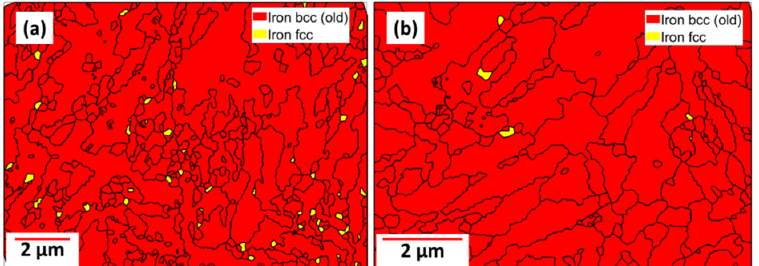
Figure 8. The modified 1.2343 as-built: ( a ) Martensite, retained austenite (Ra)~0.3%. ( b ) The modified 1.2343 as-built: tempered at 550 °C for 4 h, Ra~0%.